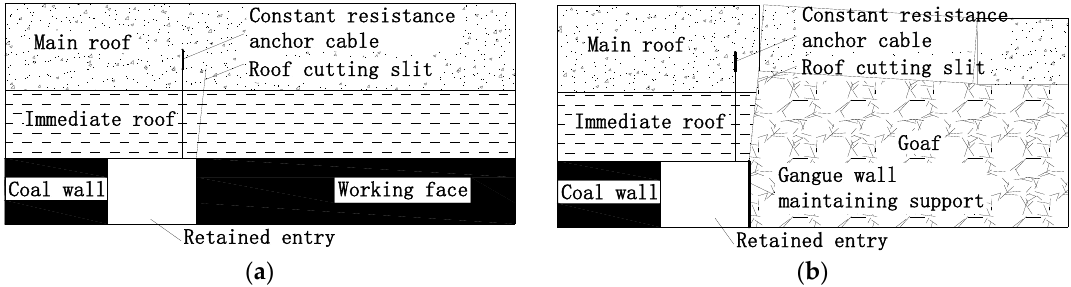
Figure 1. Sketch map of the roof cutting pressure releasing gob-side entry retaining (RCPRGER) technology: ( a ) before working face mining; ( b ) after working face mining.